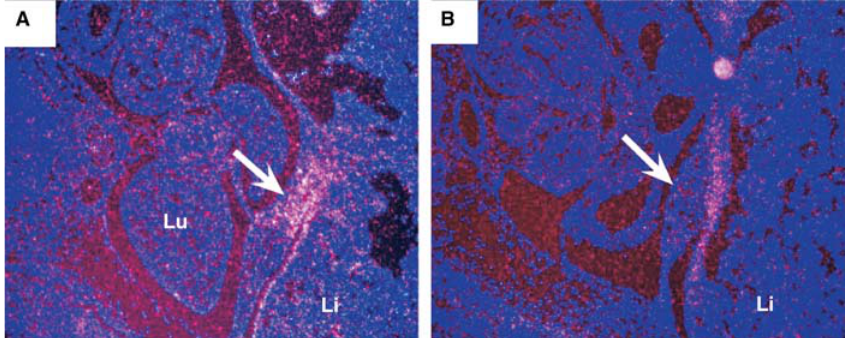
Figure 6. HGF Patterning Is Abnormal in Fog2 Null Mice In situ hybridization of HGF in E12.5 wild-type (A) and Fog2 (cid:1) / (cid:1) (B) embryos demonstrates decreased expression in the region where the PPF meets the membranous diaphragm. Li, liver; Lu, lung. DOI: